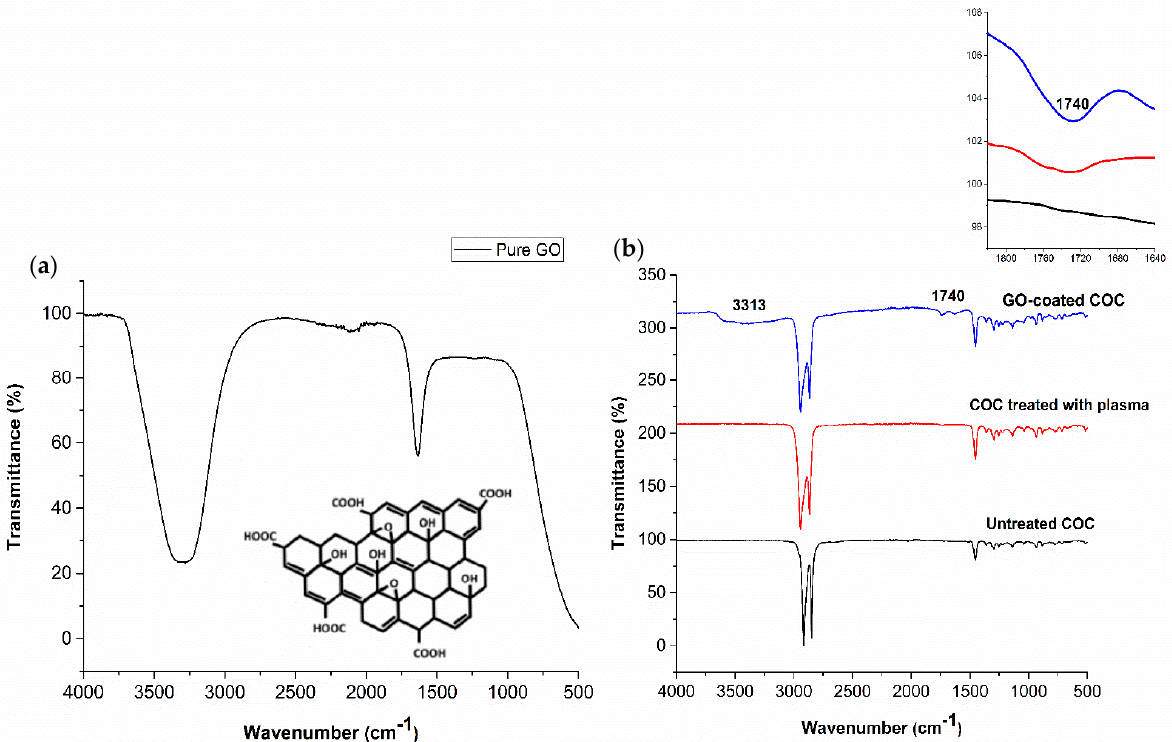
Figure 6. Typical FTIR spectra for ( a ) Graphene oxide and ( b ) untreated COC, COC treated with plasma for 5 min, and 4 mg/mL GO − coated COC.